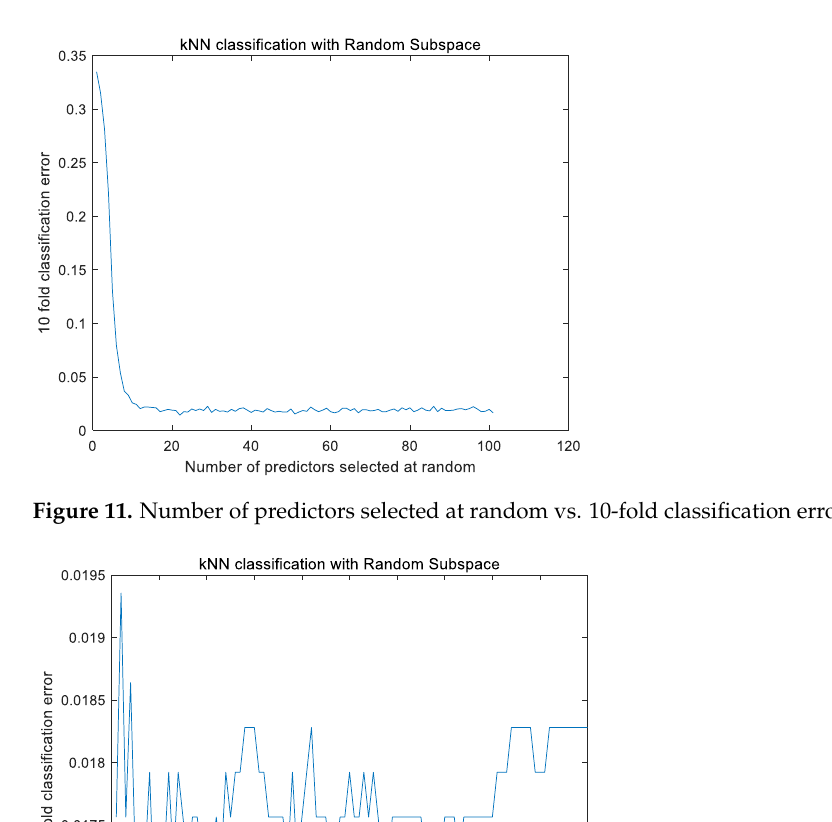
Figure 11. Number of predictors selected at random vs. 10-fold classification error for k = 1 .